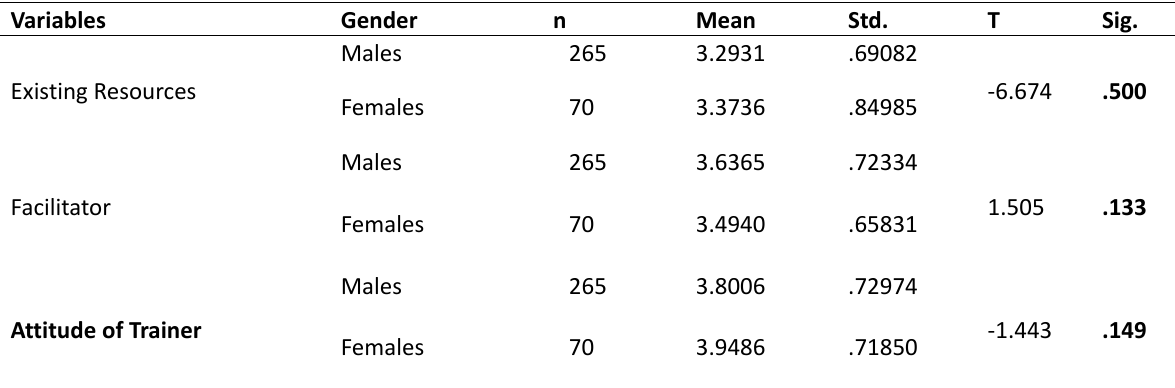
Table 4. independents sample t-test describing the results of male and female students regarding specific challenges such as existing resources, facilitators, and trainer attitude